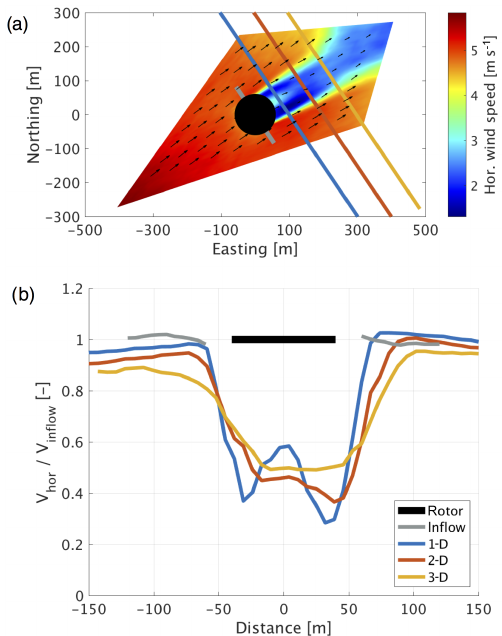
Figure 7. Wind turbine wake deficit observed with the diamond scan (10min averaged period measured on 7 June 2015 from 06:18 to 06:28): (a) diamond scan with lines indicating the position of deficit profiles; (b) wake deficit profiles. The average tip speed ratio during this period is λ = 6 . 7, and the power coefficient is c p = 1 . 7 × 10 − 4 .